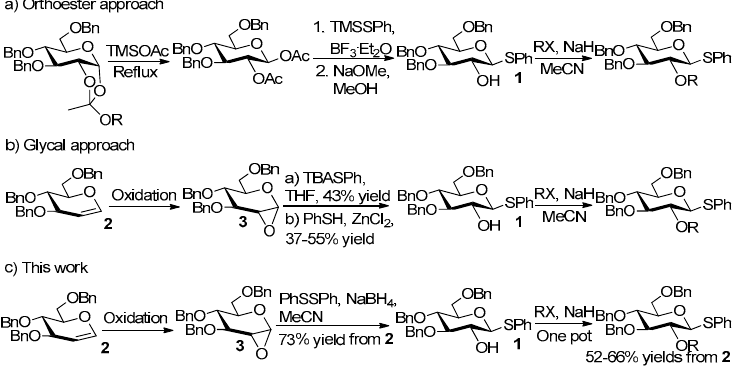
Figure 2. Comparison of this method with previous methods.